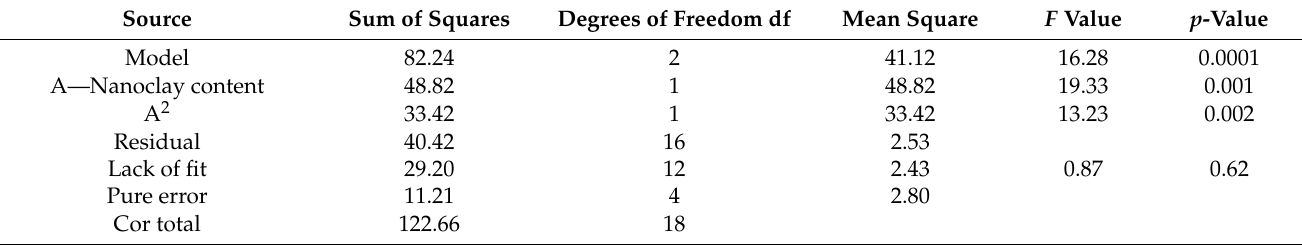
Table 5. Analysis of variance for the reduced quadratic regression model: flexural